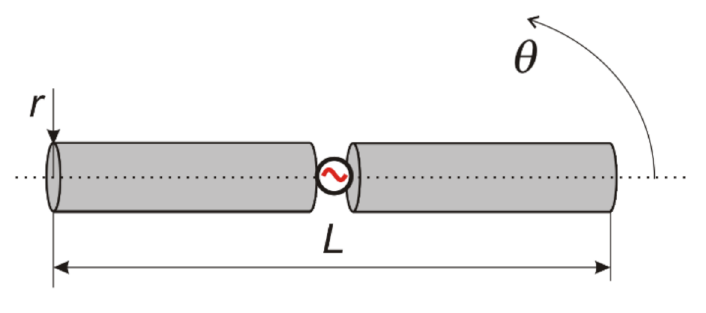
Figure 1. Dipole antenna